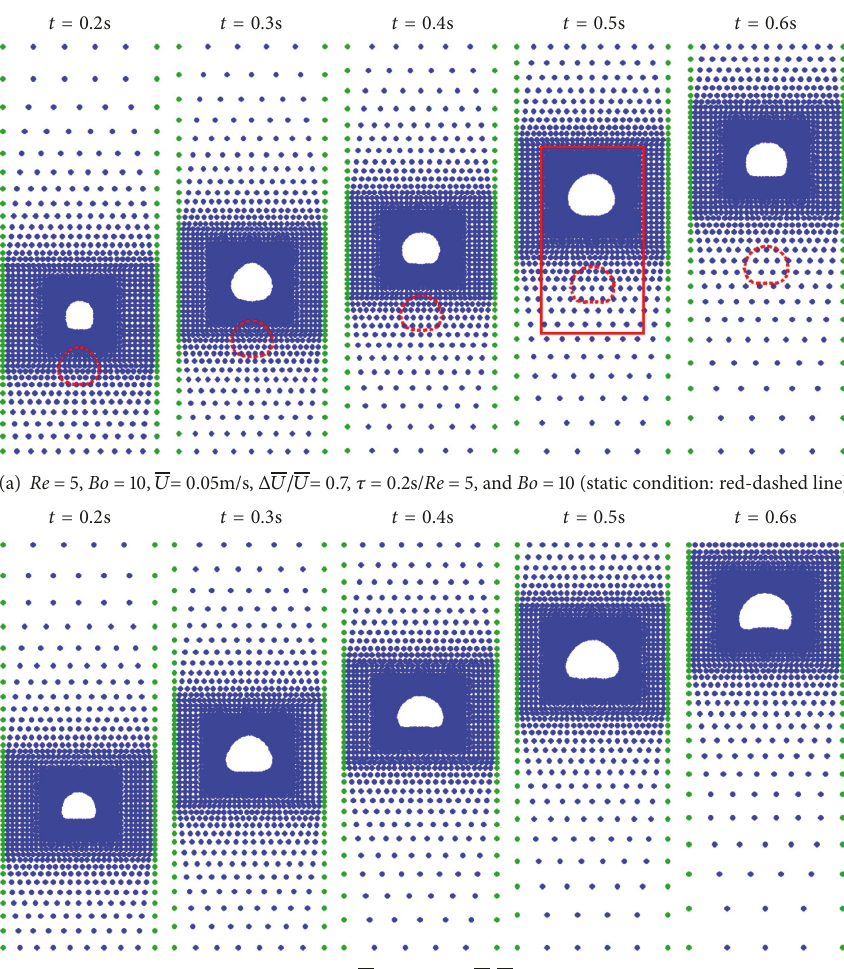
Figure 6: Shape change of single bubble rising process under pulsation condition.